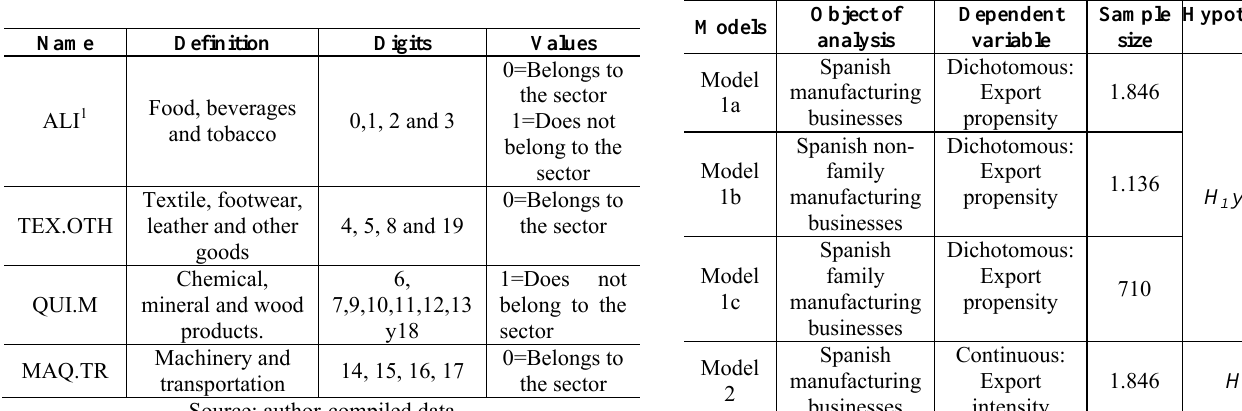
Table 4: Grouping of sectors according to data treatment